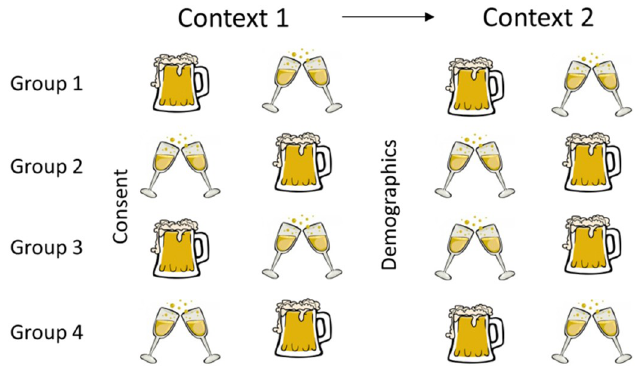
Figure 1. Diagram of the study’s set-up. Participants were placed in either the bar or winery, tasted one of each sample, changed context, and tasted each sample once more.